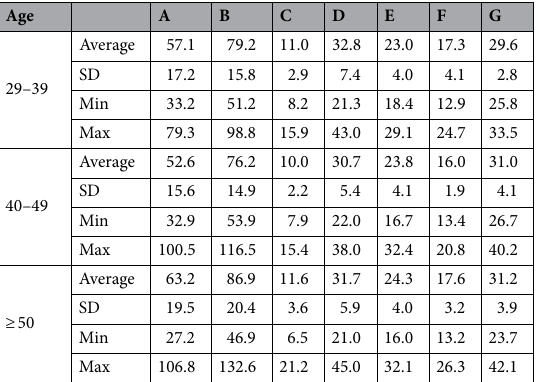
Table 3. Dimensions of the Achilles tendon in the experimental group in subjects of different age groups. A, B, C, D, F, G—dimensions of the Achilles tendon; definitions in the Material and methods, min.—minimum, max.—maximum, SD—standard deviation.